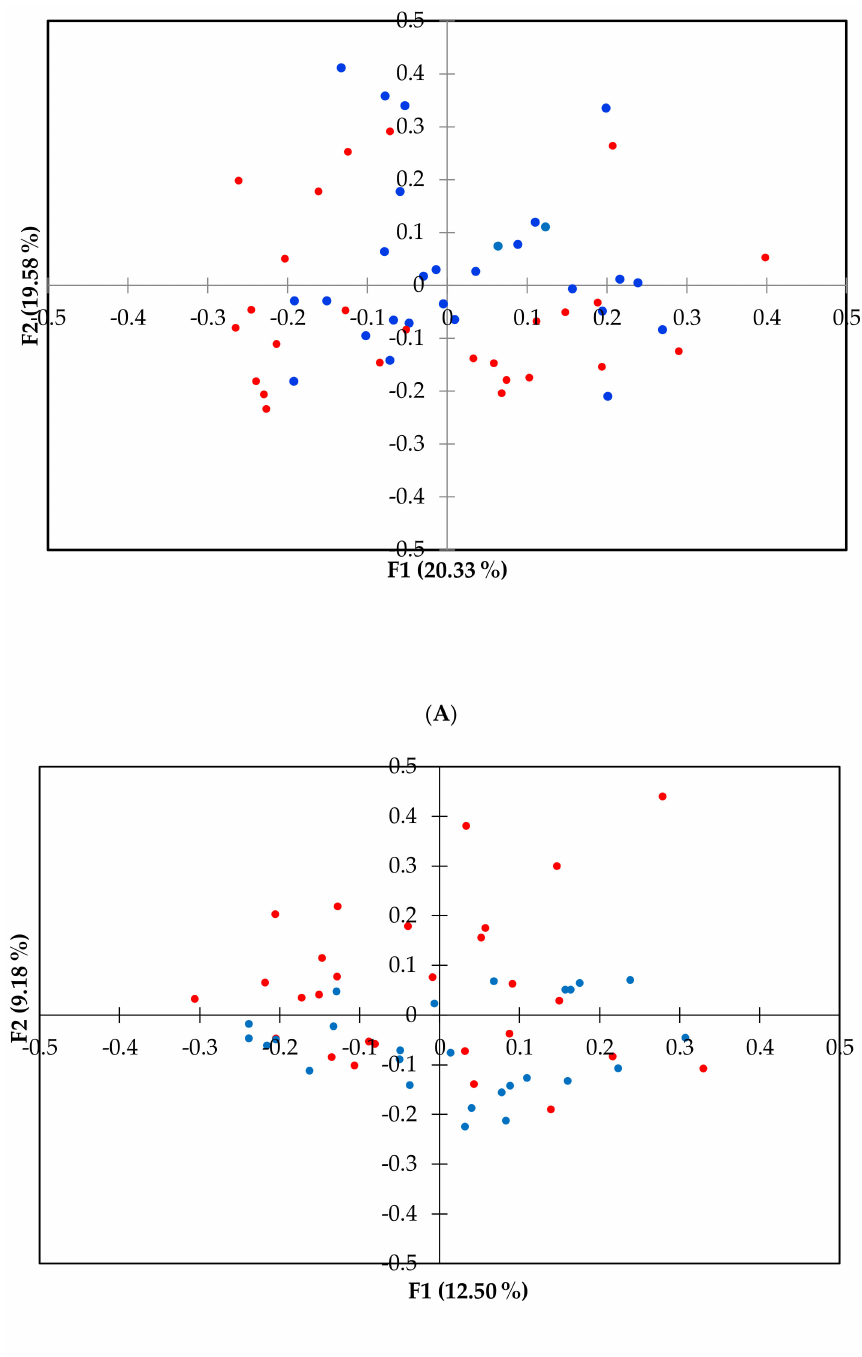
Figure 2. Principal coordinate (PCoA) plot representing the beta diversity of the microbial community among dogs’ health status at family ( A ) and genus ( B ) level. PCoA was calculated using the Brain Curtis dissimilarity matrix. Dots in red represent arthritic dogs (AD), and dots in blue represent the healthy dogs (HD). The analysis of similarity (ANOSIM) was significant at the family level for p <